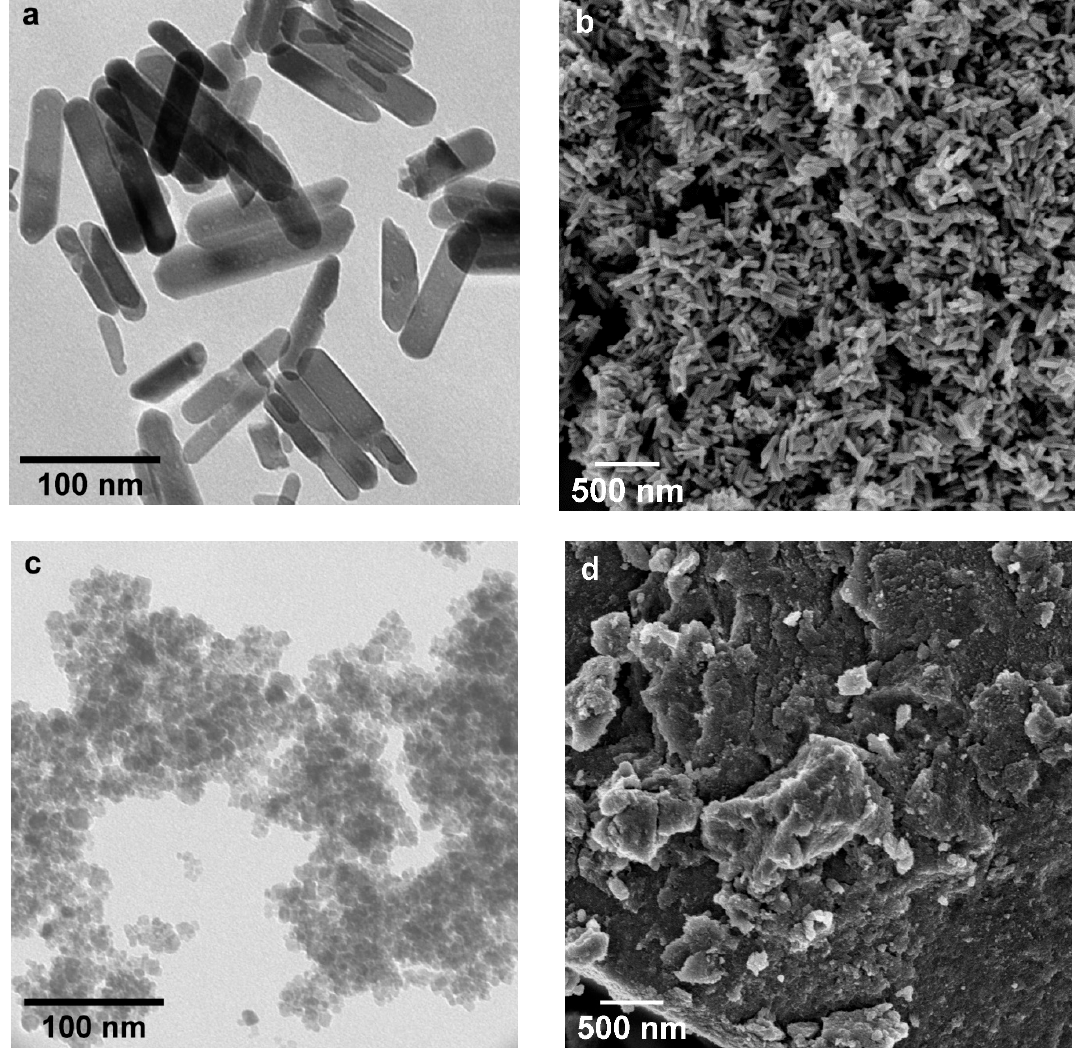
Figure 3. The microstructure of the sample, prepared by hydrothermal treatment of titanium lactate complex at 180 °C in the presence of urea without the addition of phosphate (sample TiP0, ( a ) TEM image, ( b ) SEM image); and the microstructure of the sample prepared by hydrothermally treating the titanium lactate complex at 180 °C in the presence of urea with a Ti:P ratio of 1:0.5 in the reaction mixture (TiP0.5, ( c ) TEM image, ( d ) SEM image).